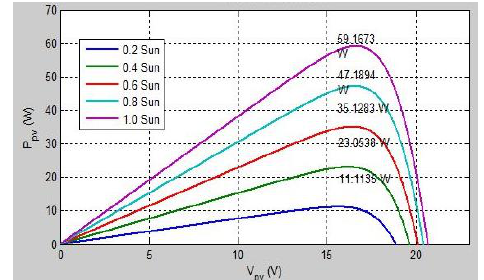
Figure 4. P-V Characteristics of SPV System